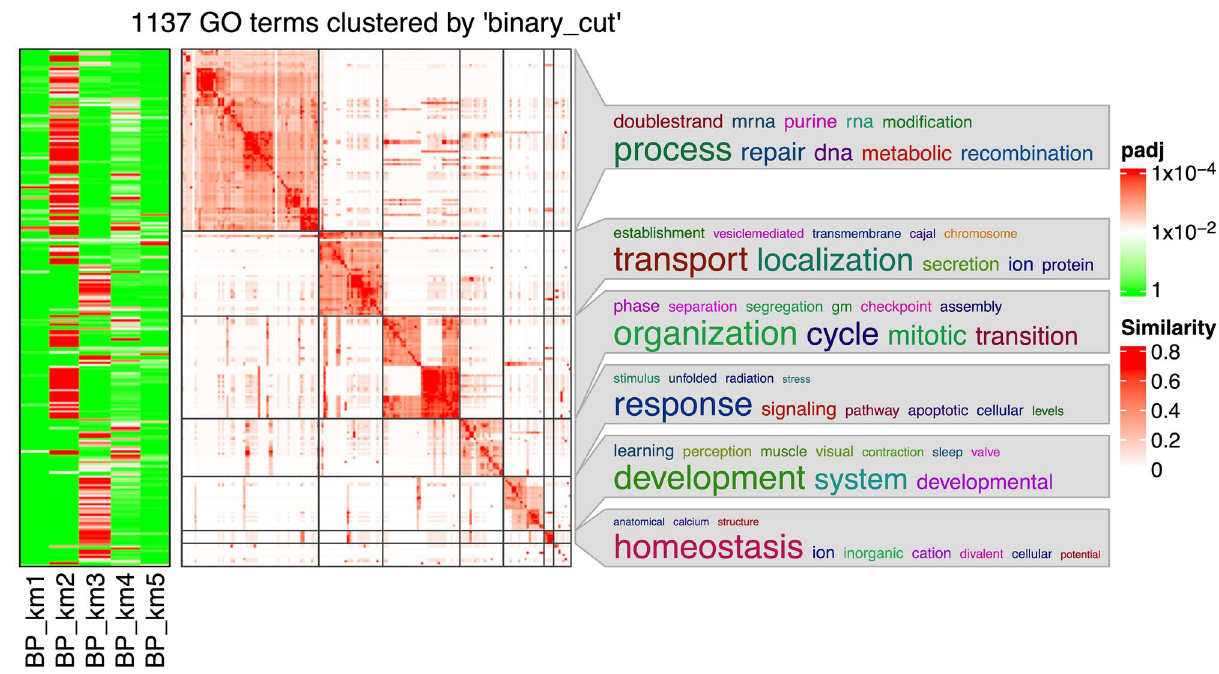
Figure 4. Heatmap of the GO term similarities from the 195-sample gene list. The terms resulted from the enrichment of the genes in either group (using FDR < 0.01). The green–red columns show for which group the respective GO terms are significant. The word cloud keywords highlight the biological functions in each GO group.